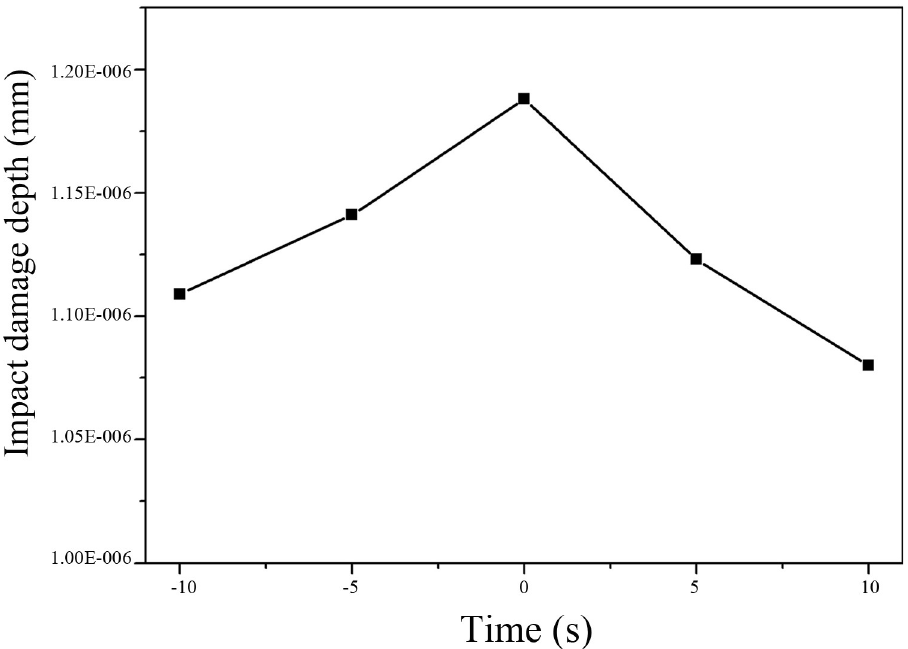
Fig 8. Impact damage depth curve of the middle trough under the different front lean angles.